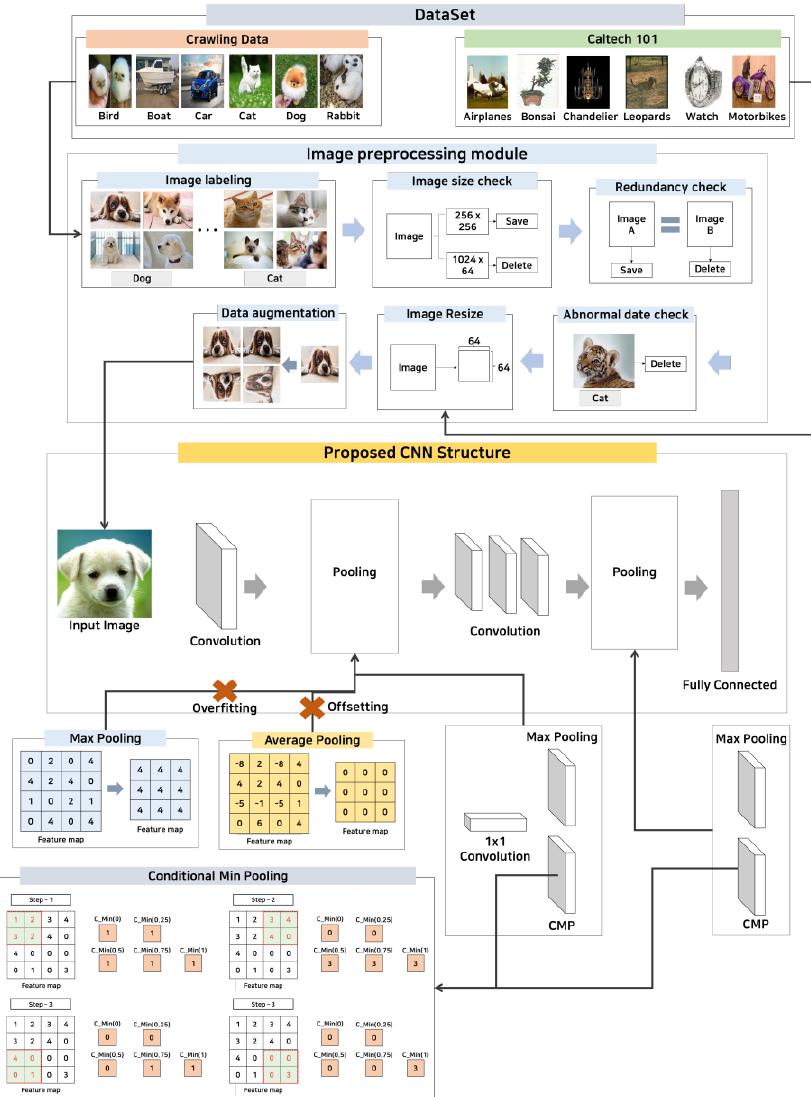
Figure 1. Overall structure of proposed pooling structure.